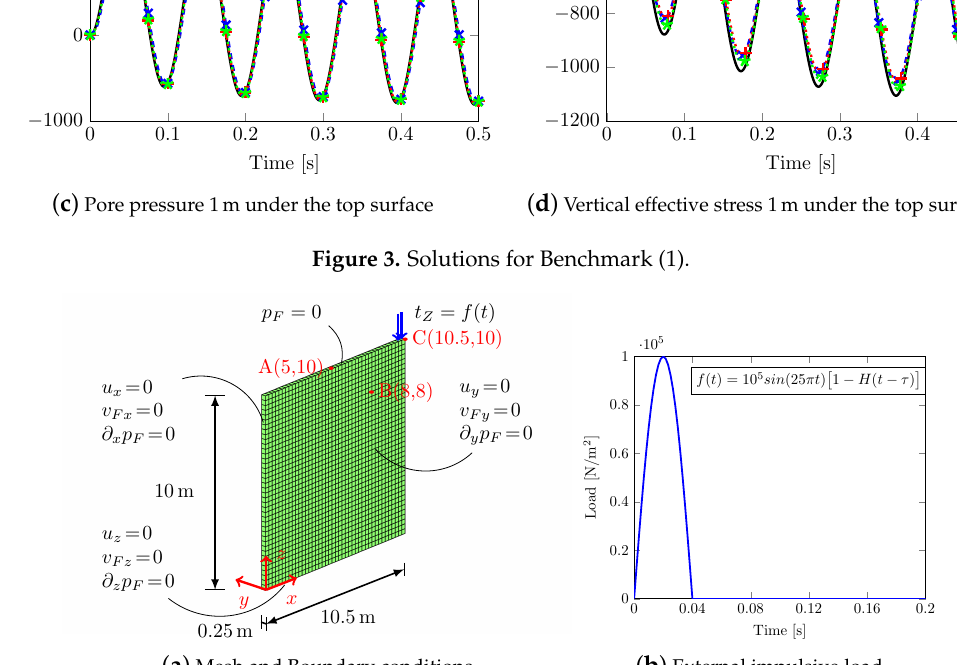
Figure 4. 2D model (Benchmark